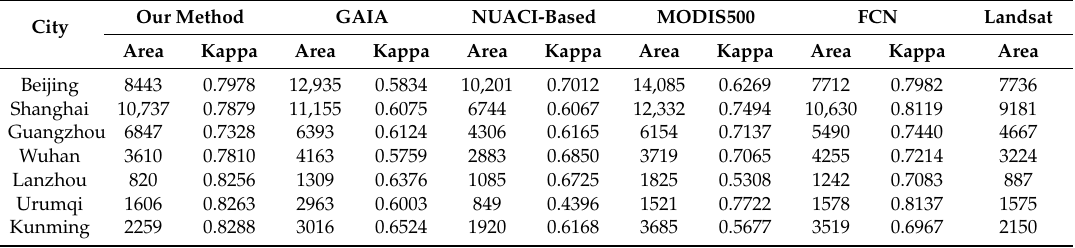
Note: “Area” means the number of urban pixels in spatial resolution 500 m, and “Landsat” means the urban extent obtained from